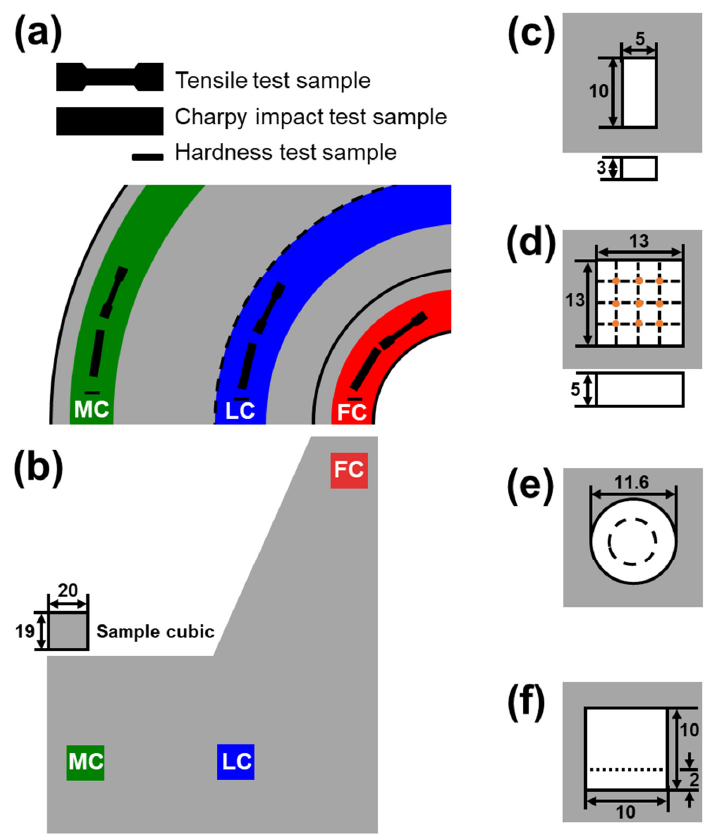
Figure 3. Schematic illustration of testing location in flange for samples. ( a ) Horizontal direction, ( b – f ) vertical direction, ( c ) microstructure, ( d ) hardness test (marked as orange), ( e ) tensile test, ( f ) Charpy impact test. Dimensions: mm.